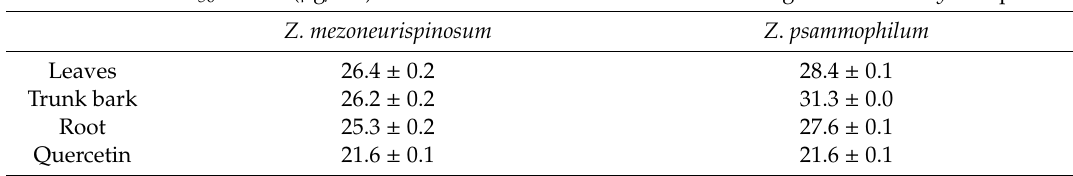
Table 2. Lipoxygenase inhibitory activity. Data are expressed as the mean of